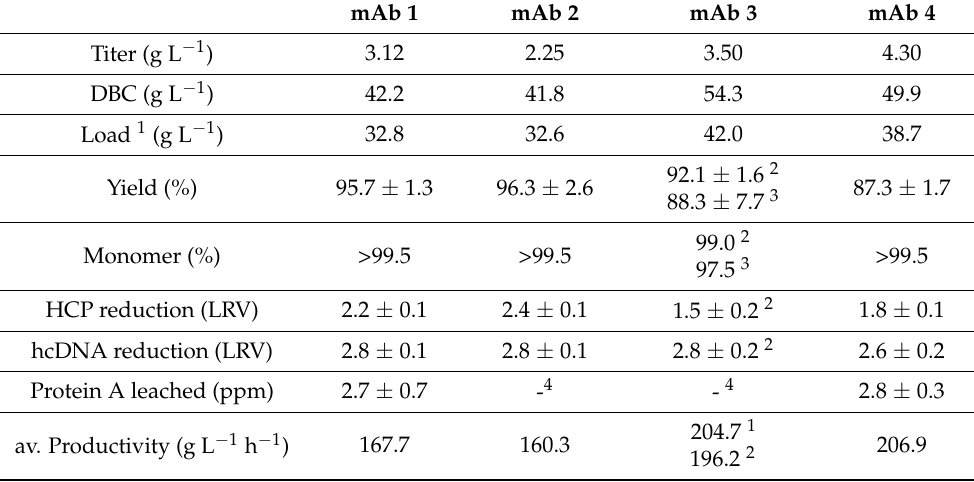
Table 4. Overview of process-related parameters and product quality